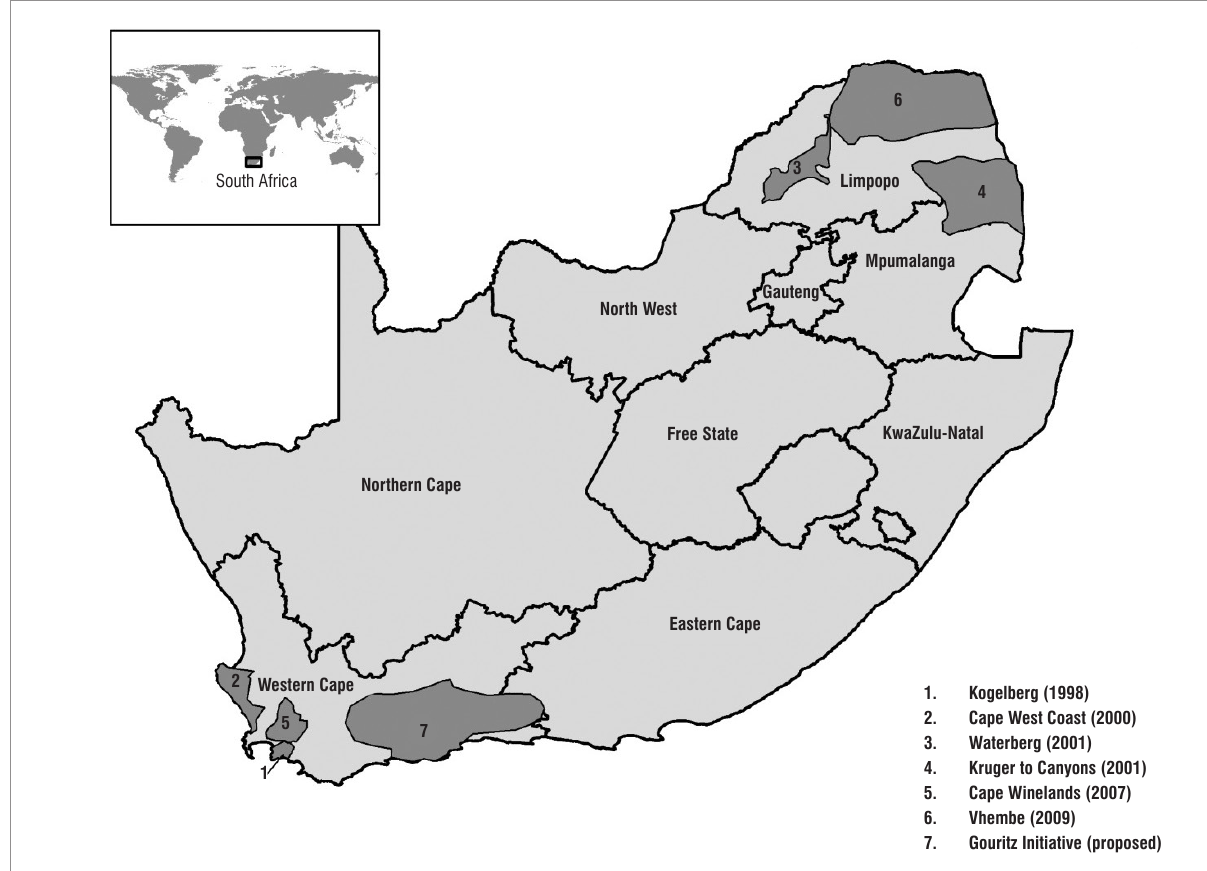
Figure 1: Location of biosphere reserves in South